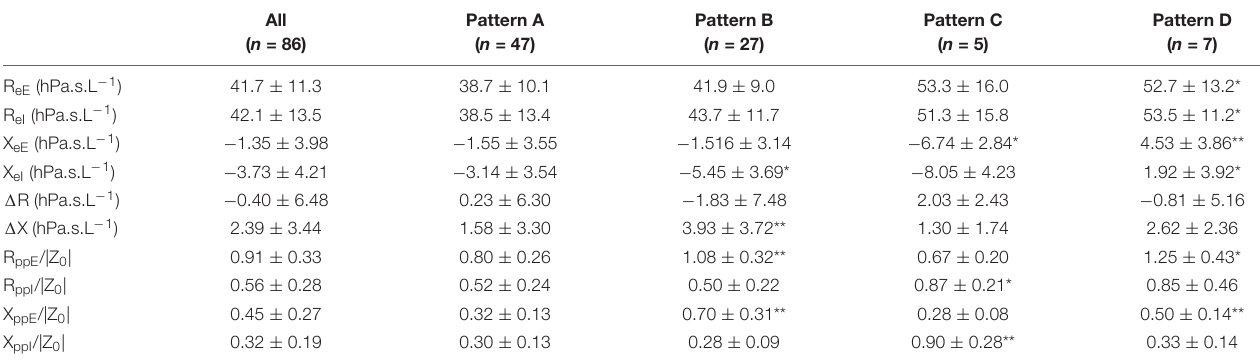
TABLE 3 | Comparison of intra-breath oscillometry data between subject groups of different patterns of flow dependence of respiratory reactance.